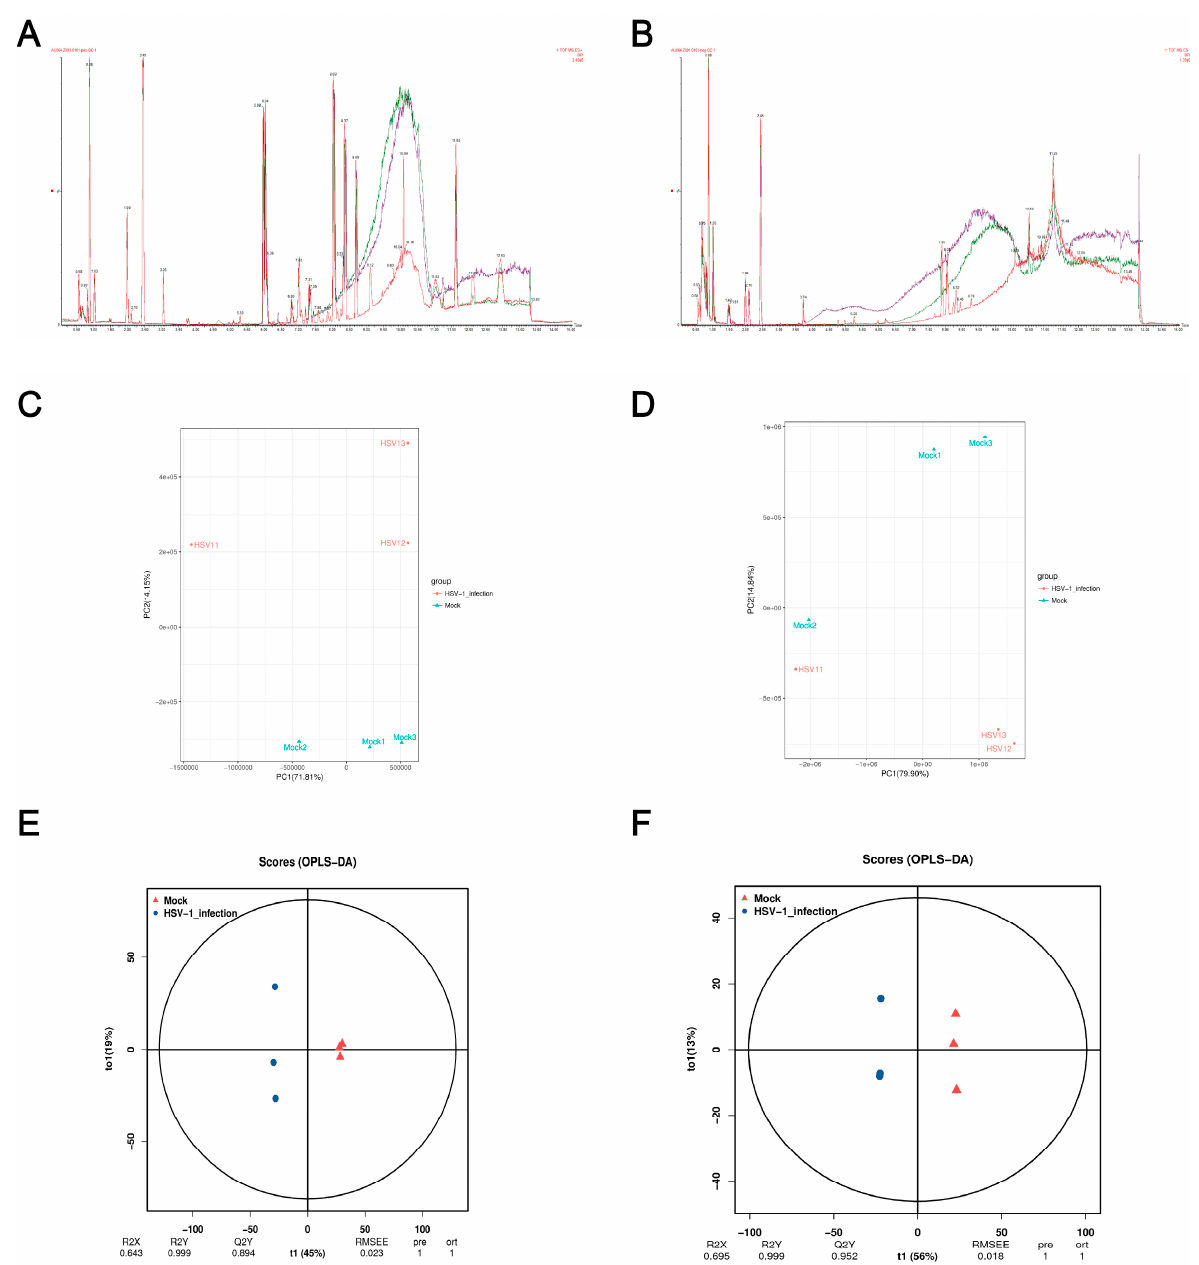
Figure 2. Quality control (QC) and multivariate statistical analysis. ( A , B ) Total ion BPI overlap plots of QC samples in positive and negative ion modes. ( C , D ) Principal component analysis diagram of difference grouping under positive and negative ion mode. Where the X-axis represents the first principal component, and the Y-axis represents the second principal component. Each point in the figure represents a sample. Samples in the same group are represented with the same color, and samples in different groups are marked with different colors. ( E , F ) OPLS-DA score in positive and negative ion mode. The X-axis (t1) represents the predictive component (inter-group difference component), the Y-axis (t2) represents the orthogonal component (intra-group difference component), and the percentage of the transverse Y-axis represents the proportion of the component in the total variance. At the bottom of the figure are the parameters of the model, including R2X, R2Y, Q2Y, RMSEE (root mean square error), pre (number of predicted components), and ort (number of orthogonal components).